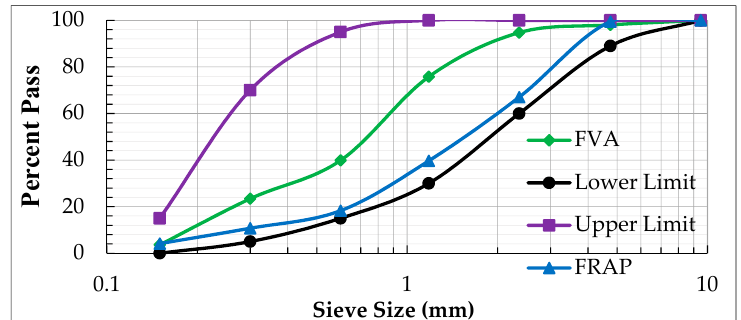
Figure 3. Fine aggregate particle size distribution as per BS 882 specifications.